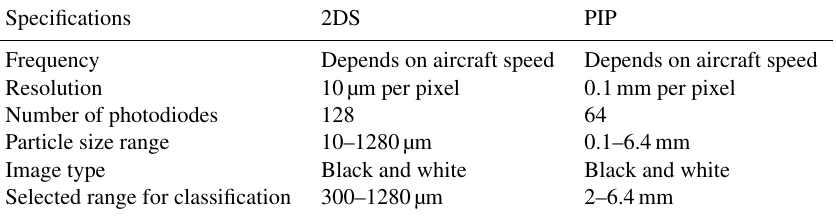
Table 1. Optical array probe technical specifications.